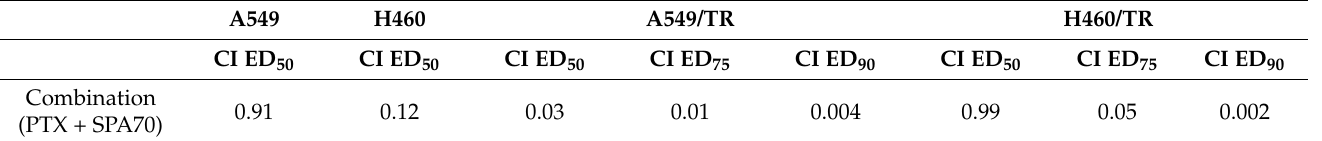
Table 2. Combination of PTX with SPA70 showed a synergistic effect in PTX-resistant cancer cell